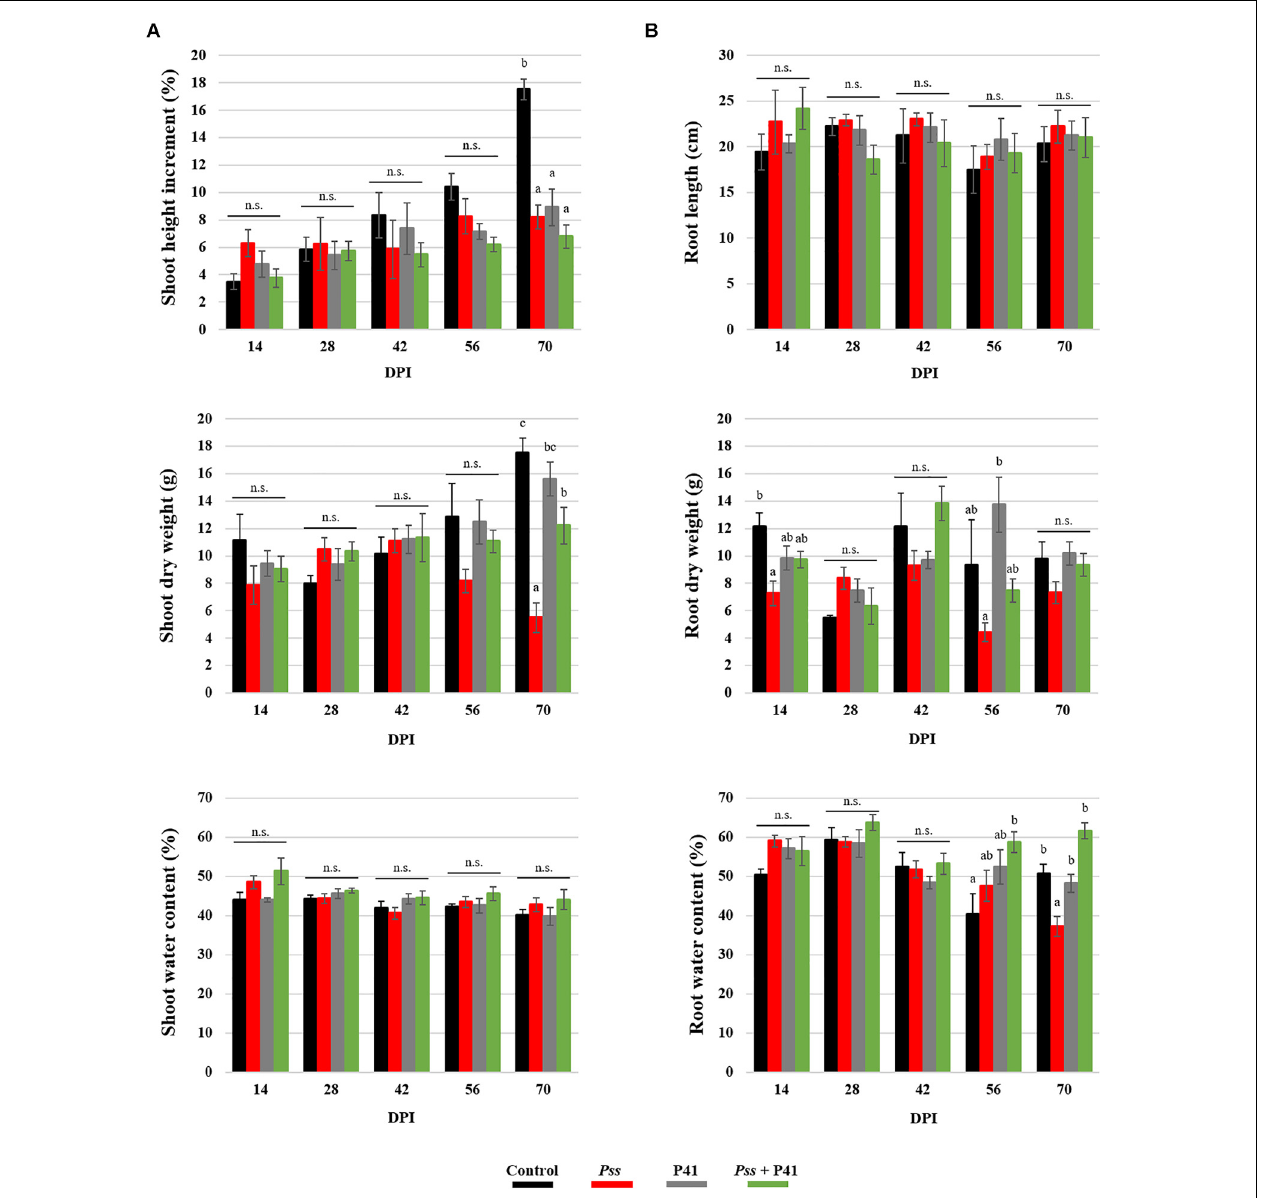
FIGURE 5 | Effect of Bacillus amyloliquefaciens (P41 isolate) on olive plant growth determined by in planta assays. Plant growth parameters were evaluated at the level of shoots (A) and roots (B) of olive plantlets inoculated with the pathogen ( Pss ), with both antagonist and pathogen ( Pss + P41), with the antagonist (P41) and with LB medium (negative control). Data is presented as means ± SE ( n = 5). Statistically significant ( p < 0.05) differences between the four treatments, in each day post-inoculation (DPI), are indicated by different letters